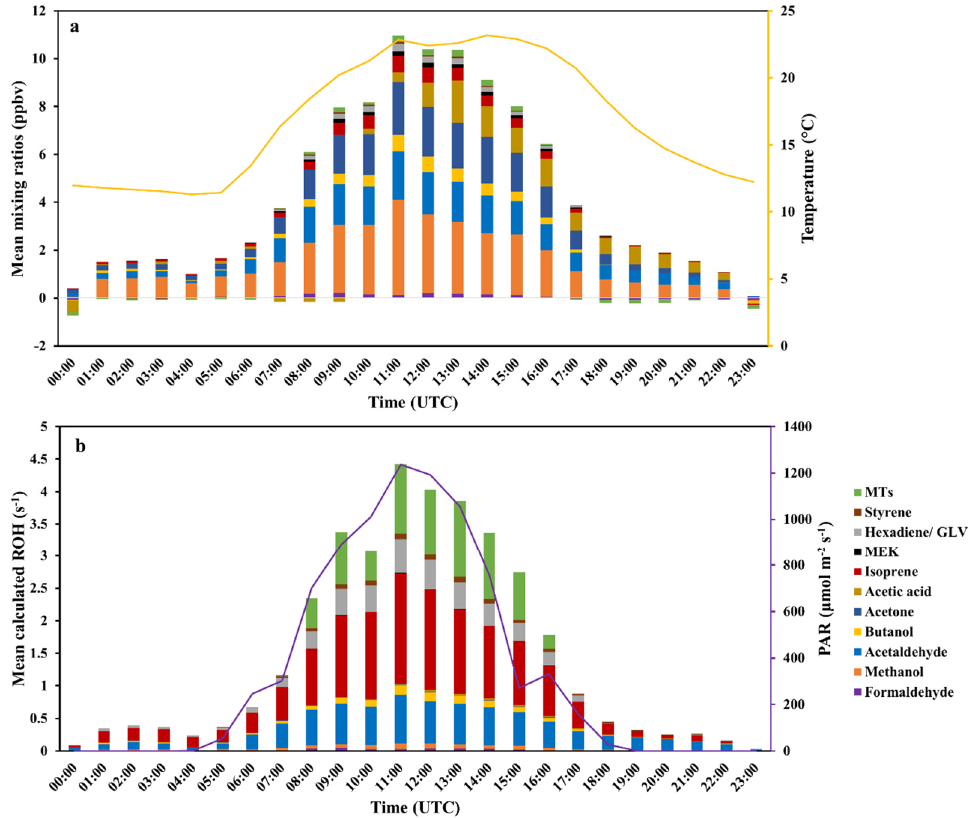
Figure 4. Averaged diurnal variation of ( a ) the mixing ratio of each biogenic volatile organic compound (BVOC) measured with the PTRQi-ToFMS (ppbv) and ( b ) their contribution to OH reactivity (s − 1 ).